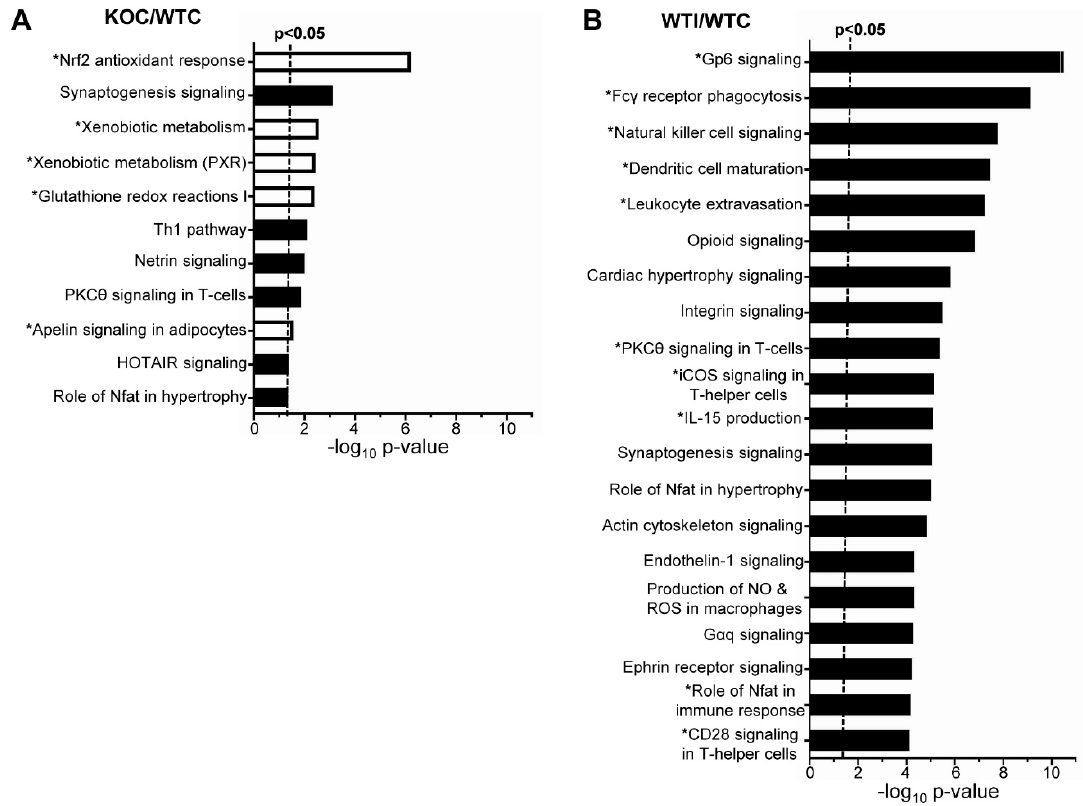
Figure 4. ( A ) Top canonical pathways enriched among DEGs (mRNAs) in Nrf2 KO mice compared to WT mice (KOC / WTC) ranked by p -value, as assessed by Ingenuity Pathway Analysis (IPA). The absolute z -score was set at ≥ 1.5. White bars indicate downregulation of the respective pathway (negative z -score), while black bars indicate upregulation of the respective pathway (positive z -score). The asterisk (*) before the pathway name indicates that it is relevant to Nrf2 signaling. ( B ) Top canonical pathways enriched in WT mice after iodide (WTI / WTC) ranked by p -value (as assessed by IPA). Absolute z -score was set at ≥ 2. Black bars indicate upregulation of the respective pathway (positive z -score). The asterisk (*) before the pathway name indicates that it is relevant to inflammatory / immune processes. Only pathways with − log 10 p -value > 4 are depicted. Table S3 (Supplementary Materials) lists all enriched pathways with absolute z -score ≥ 2 and p <